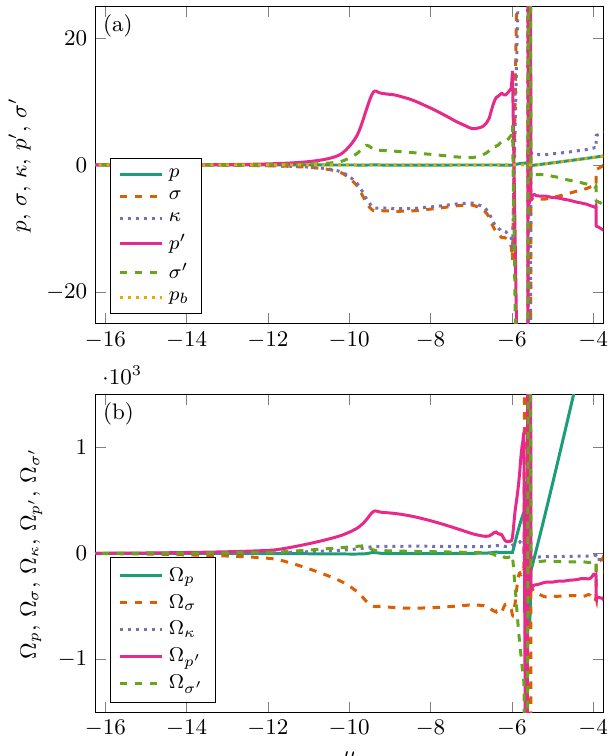
Figure 9. ( a ) Dimensionless Minkowski functional coefficients: pressure, p ( µ , T ) , surface tension, σ ( µ , T ) , bending rigidity, κ ( µ , T ) , and the pseudo pressure and surface tension terms p (cid:48) ( µ , T ) and σ (cid:48) ( µ , T ) , as a function of the dimensionless chemical potential, µ . These are the values of the coefficients that are used in Figure 8 to reconstruct the grand potential as a function of the chemical potential. The pressure coefficient is very similar to the bulk pressure, p b . ( b ) Contribution of the Minkowski functional coefficients to the grand potential as a function of the dimensionless chemical potential for a pore size of r p = 25 ( ≈ 9 nm) and an Euler characteristic of χ = − 5. Figure 10 shows the average absolute relative error, < | (cid:101) Ω | > , as a function of the √ l min . The average square root of the minimal characteristic length scale of the system, absolute relative error is defined